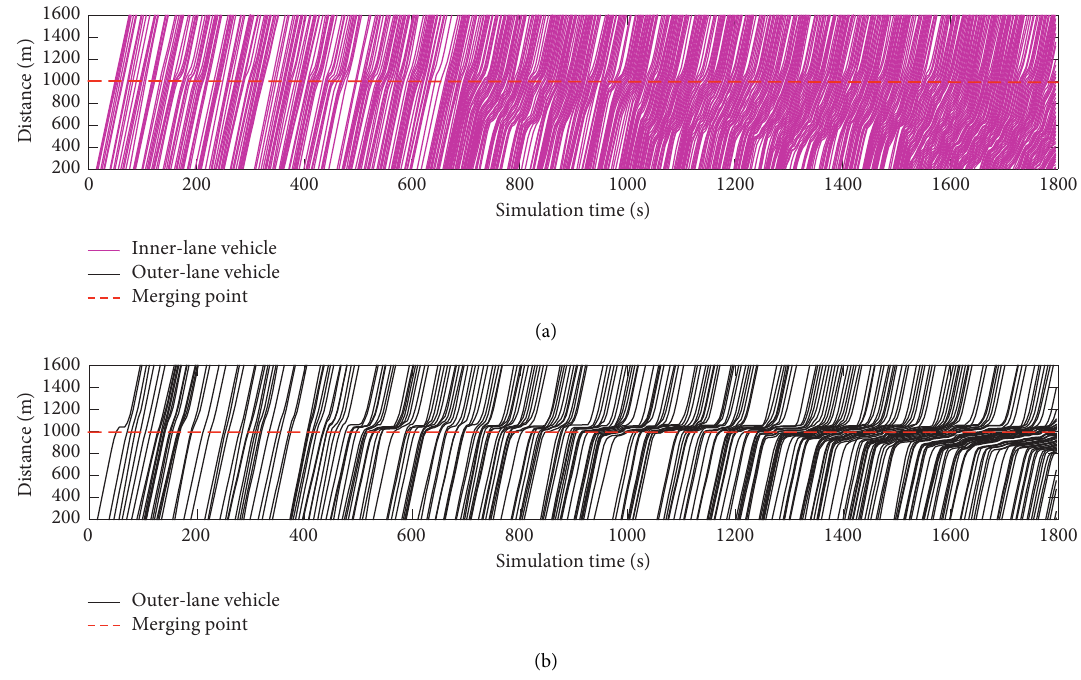
Figure 12: Scenario 2 vehicle trajectories. (a) Inner-lane vehicle trajectories. (b) Outer-lane vehicle trajectories.